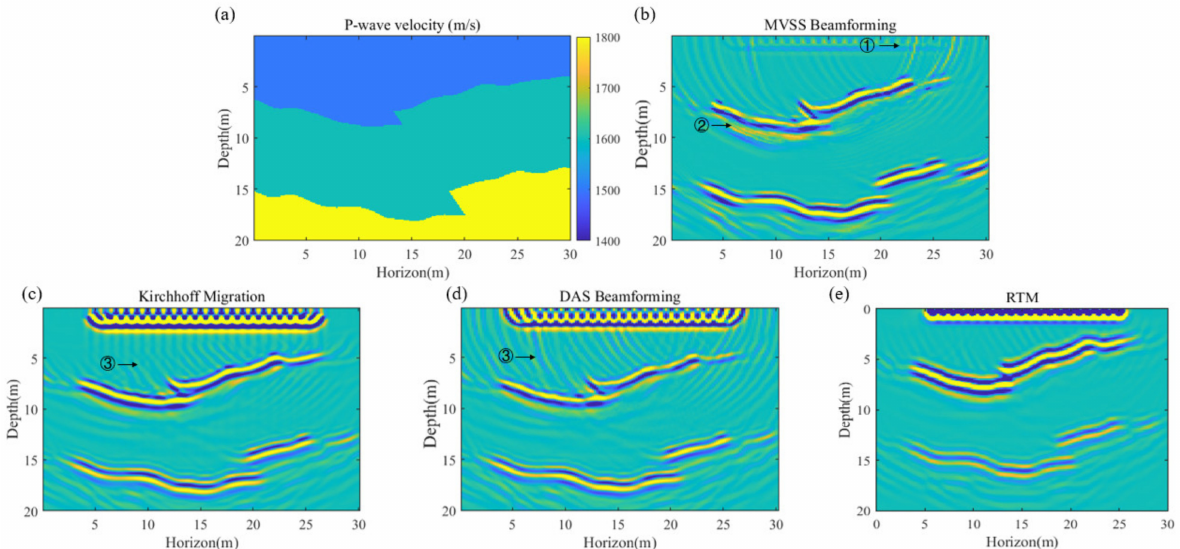
Figure 14. Model B-2. ( a ) True velocity model. ( b ) Imaging result of MVSS beamforming. ( c ) Imaging result of Kirchhoff migration. ( d ) Imaging result of DAS beamforming. ( e ) Imaging result of